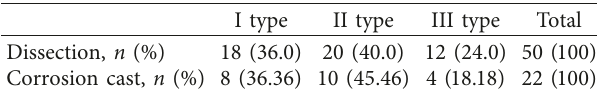
Figure 8: Type III vascular supply of the pancreas (corrosion cast). 1: splenic artery; 2: splenic vein; 3: superior horizontal artery of Popova; 4: caudal artery; and 5: spleen. Table 1: Types of pancreas vascularization and their frequency.